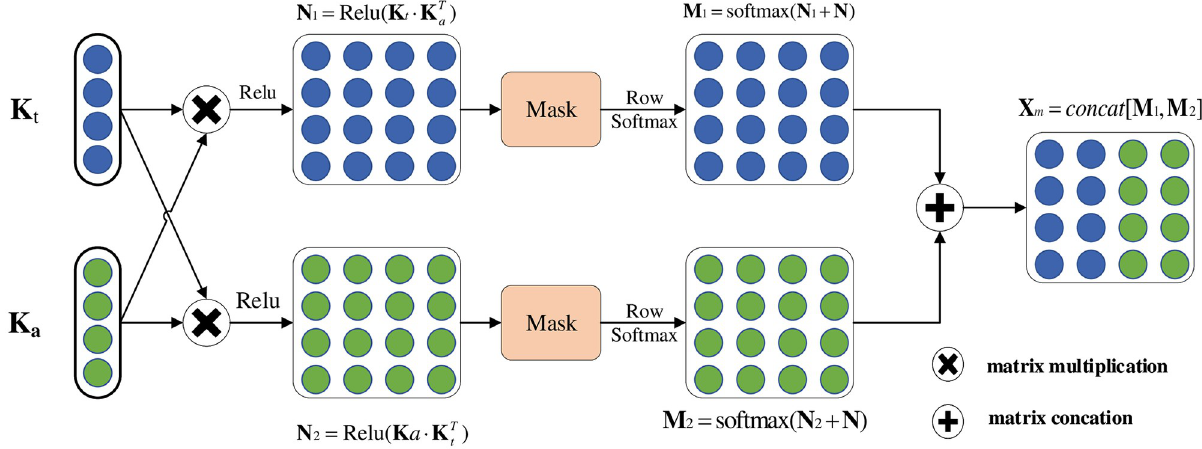
Fig 3. Cross-modal fusion attention mechanism structure. ( K softmax, concat) are all function calculations. (Mask) is a matrix.